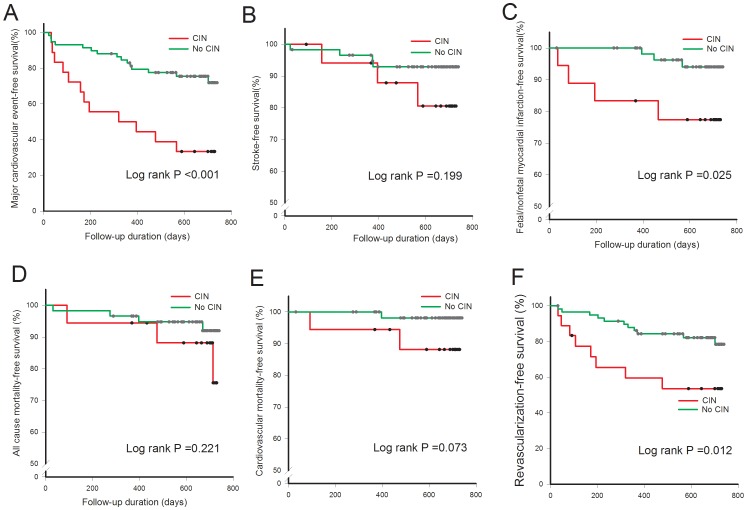
Association between contrast-induced nephropathy and major cardiovascular events (MACE), (A) MACE including stroke, fatal/nonfatal myocardial infarction, death and revascularization of treated vessels; (B) Stroke; (C) fatal/nonfatal myocardial infarction; (D) all-cause mortality; (E) cardiovascular death; (F) revascularization of treated vessels.